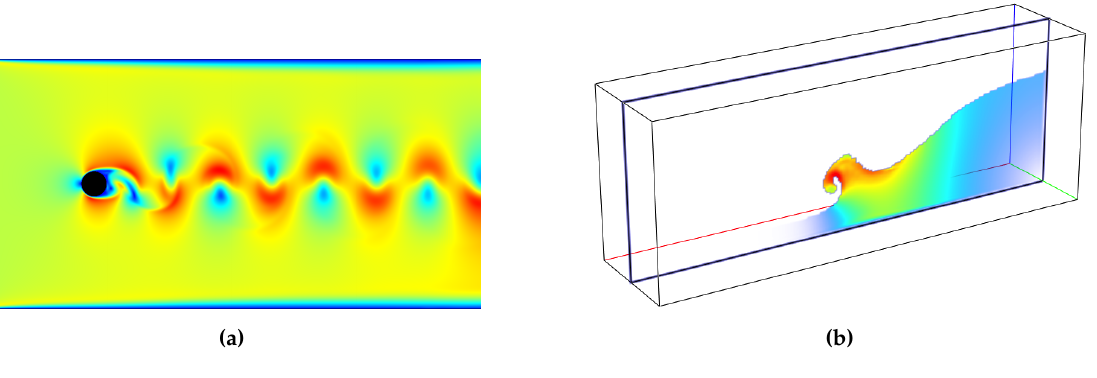
Figure 2. Colored slice applied to ( a ) a flow around a cylinder and ( b ) the dam break test